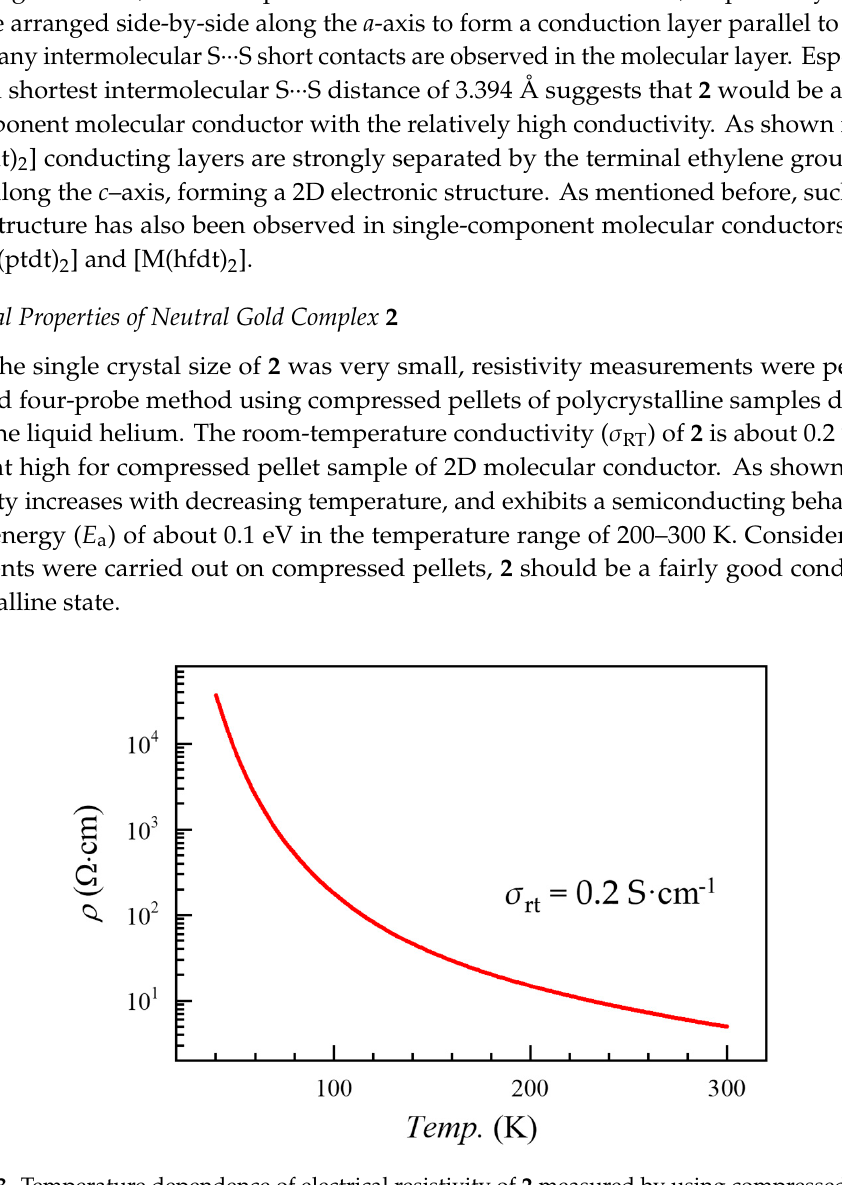
Figure 4. Temperature dependence of magnetic susceptibility of 2 at the field of 5000 Oe. The blue line is the Curie–Weiss fitting curve as described in the text. 3.5. Electronic Structures and Band Structure Calculations of Neutral Gold Complex 2 The MO, band structure, and DOS calculations were performed by the DFT method. The spin polarized molecular orbitals and the energy levels of the neutral [Au(etdt) 2 ] molecule are shown in Figure 5a. The frontier orbitals near the Fermi level are very similar to those of reported gold dithiolate complexes with extended-TTF ligands, such as [Au(tmdt) 2 ]. The singly occupied molecular orbital (SOMO) of [Au(etdt) 2 ] is composed of an anti-symmetric combination of the left- and right-